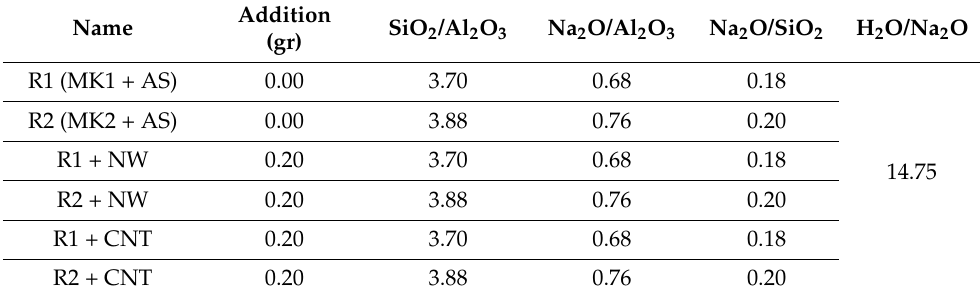
Figure 6. Scheme of experimental procedure for mix preparation. Table 4. Molar ratios from each mixture and additions content incorporated.